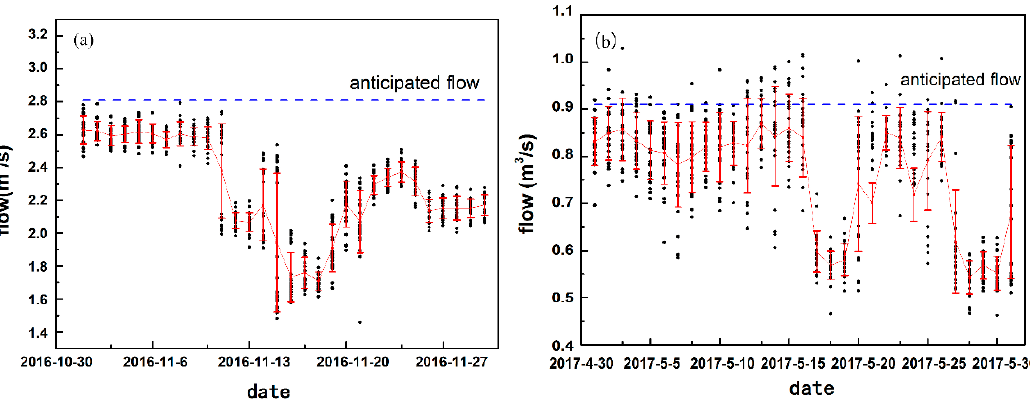
Figure 2. Regular fluctuations of diversion flows. ( a ): monitoring data in 2016, ( b ): monitoring data in 2017.